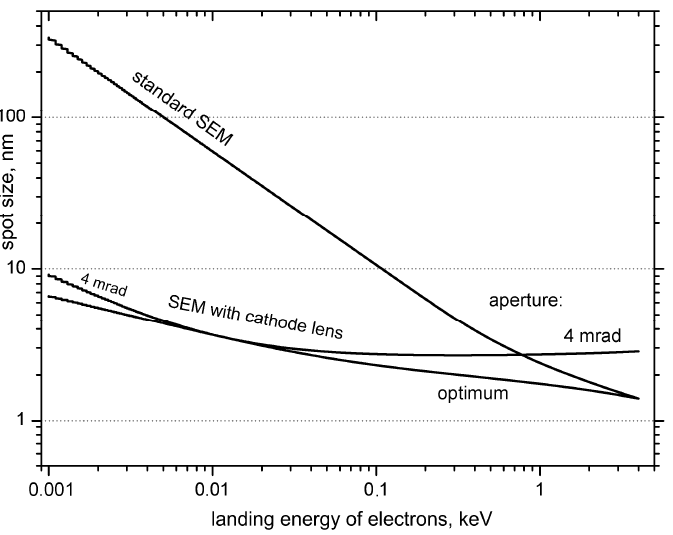
Figure 4. An example of the spot size data calculated from approximate analytical equations [9] for the objective lens defined with spherical and chromatic aberration coefficients 7.4 and 2.5 mm, respectively, primary beam energy 4 keV, working distance 4 mm and energy spread of the beam reduced with a monochromator to 100 meV. The gun brightness was 10 8 Acm − 2 sr − 1 , the beam current was 10 pA, and the anode bore 1 mm in